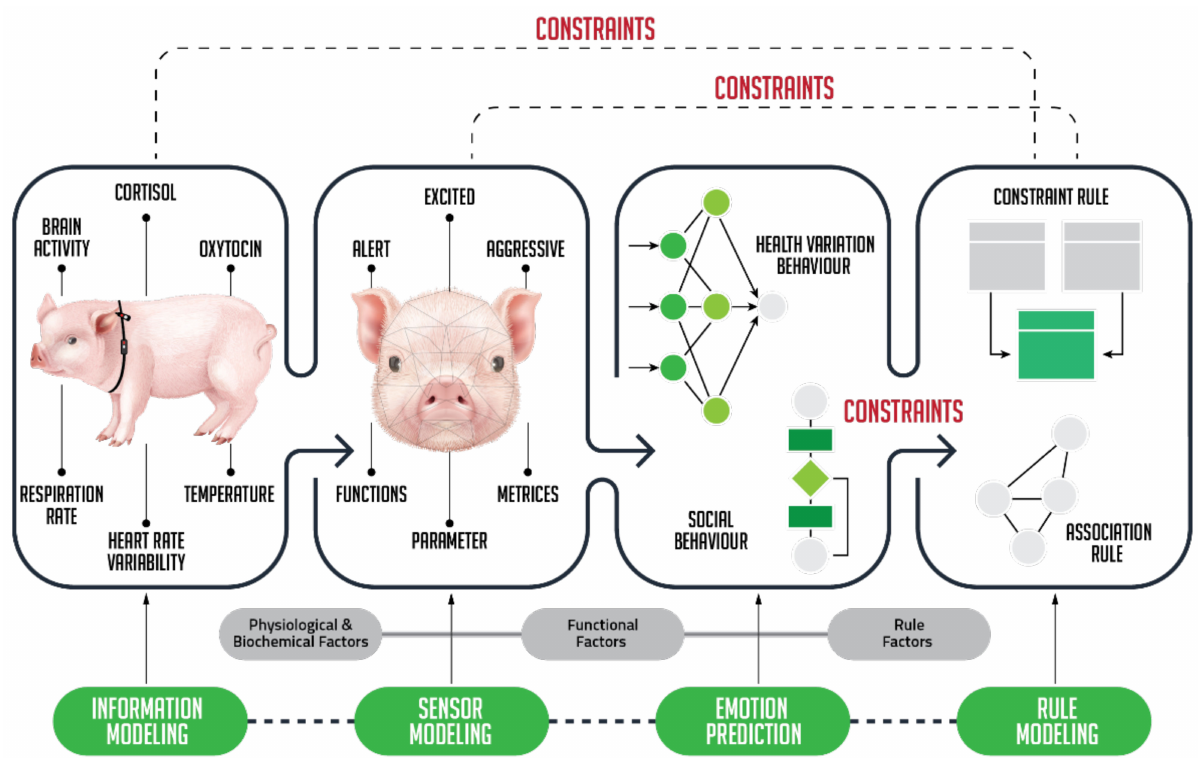
Figure 8. Sensor-based Digital Twin animal emotion modelling